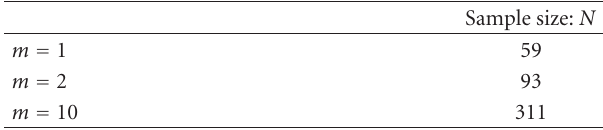
Table 2: Sample size N that guarantees a confidence value β = 0 . 95 and a coverage value γ = 0 . 95, for di ff erent numbers m of values lying above y 95 .